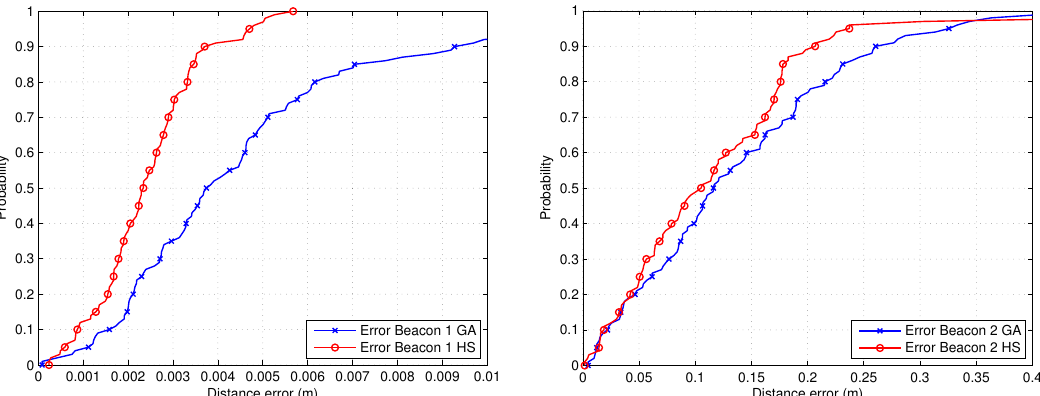
Figure 9. CDF of the error related to the estimation of the positions of beacon #1 (left) and beacon #2 (right).